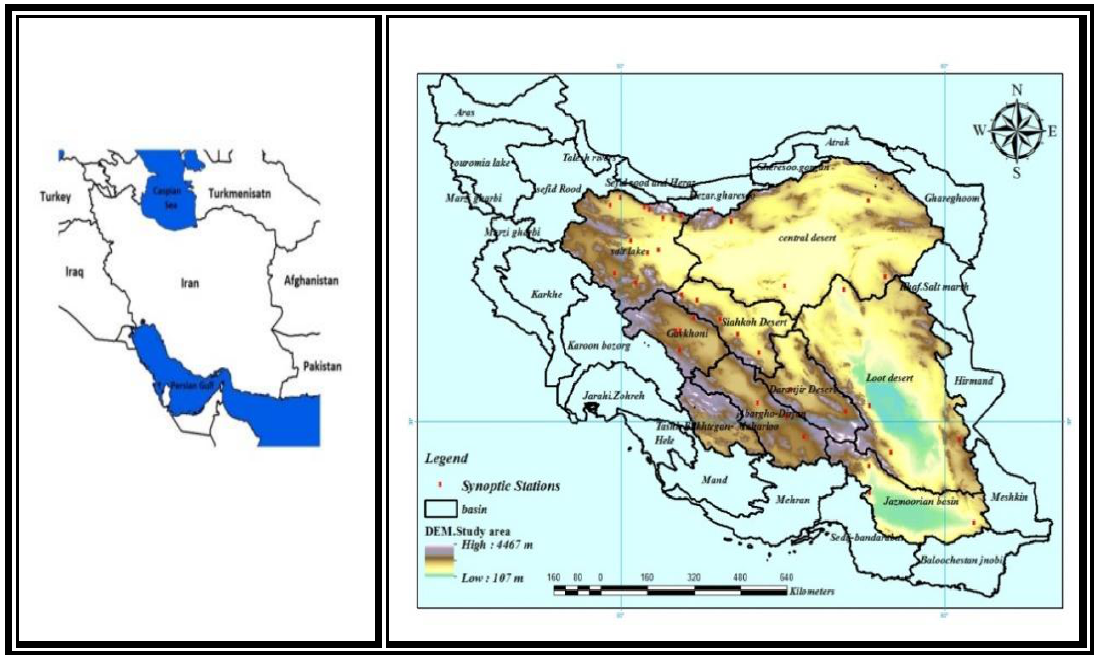
Figure 1. Topographical map of the study area (the Central Plateau of Iran), showing the locations of synoptic stations (red squares), and the main basins (black borders).